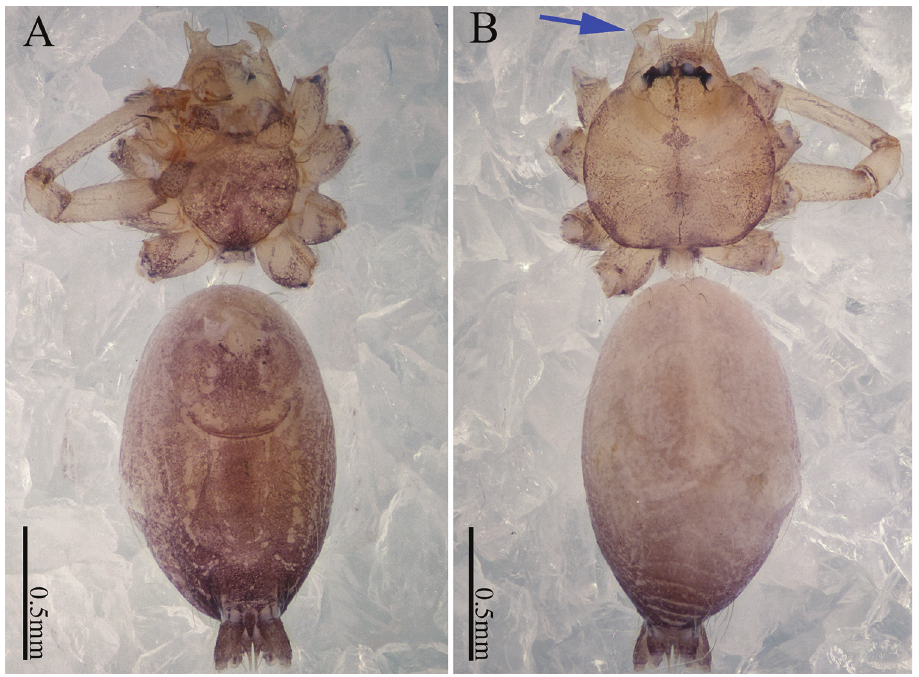
Figure 20. Sinoderces kieoensis Li & Li, sp. nov., male holotype A male habitus, ventral view B male habitus, dorsal view (Arrow: